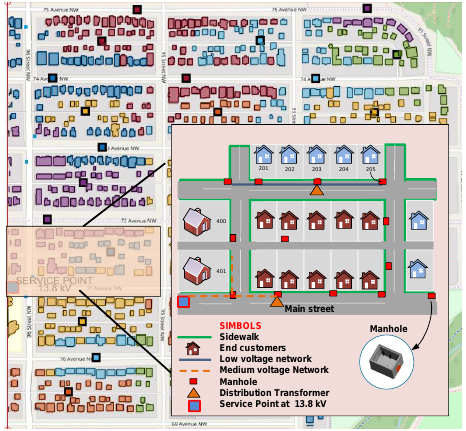
Figure 1. A schematic overview of the distribution network and its main